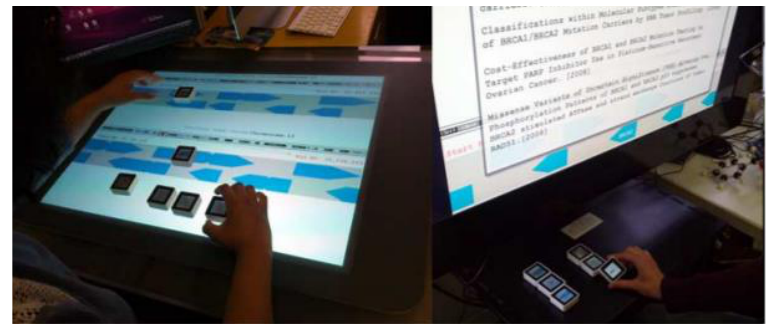
Figure 29. Using Sifteo Cubes for construction of complex database queries [50].